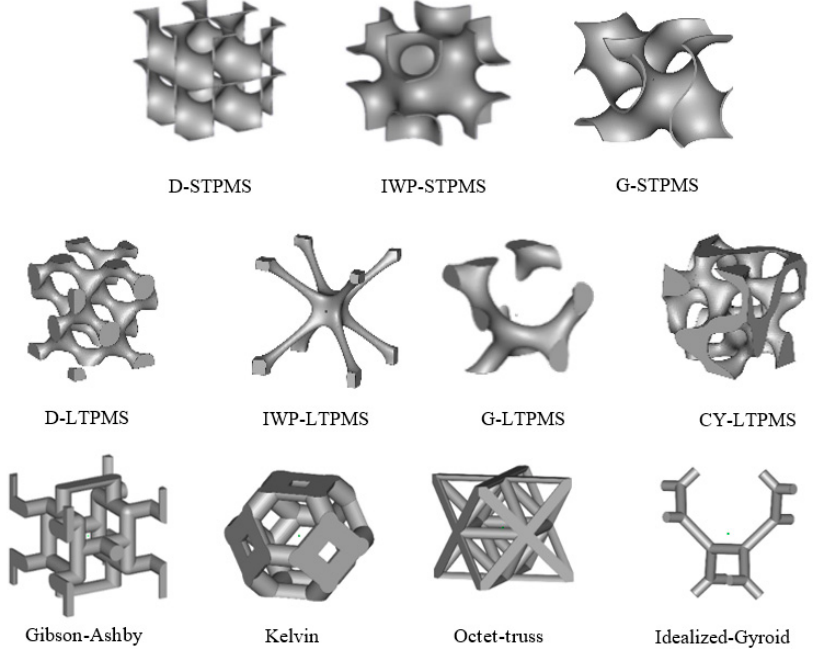
Figure 1. One-unit cell of different lattice architectural topologies: sheet-based TPMS (top), ligament-based TPMS (middle), and cellular struts (bottom). Table 1. Level set approximation equations of the TPMS topologies.